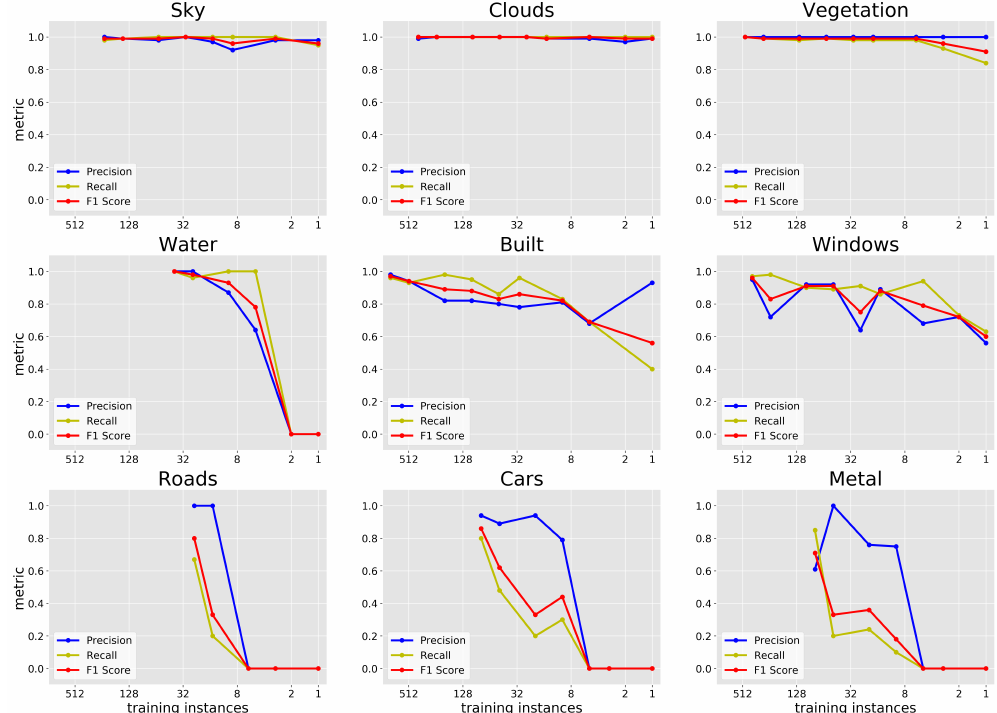
Figure 14. The same as Figure 13 but for per class performance. Clouds and Vegetation pixels maintain a high precision and recall regardless of the number of training instances used, while the remaining classes show reduced precision, recall, or both as the number of training pixels is